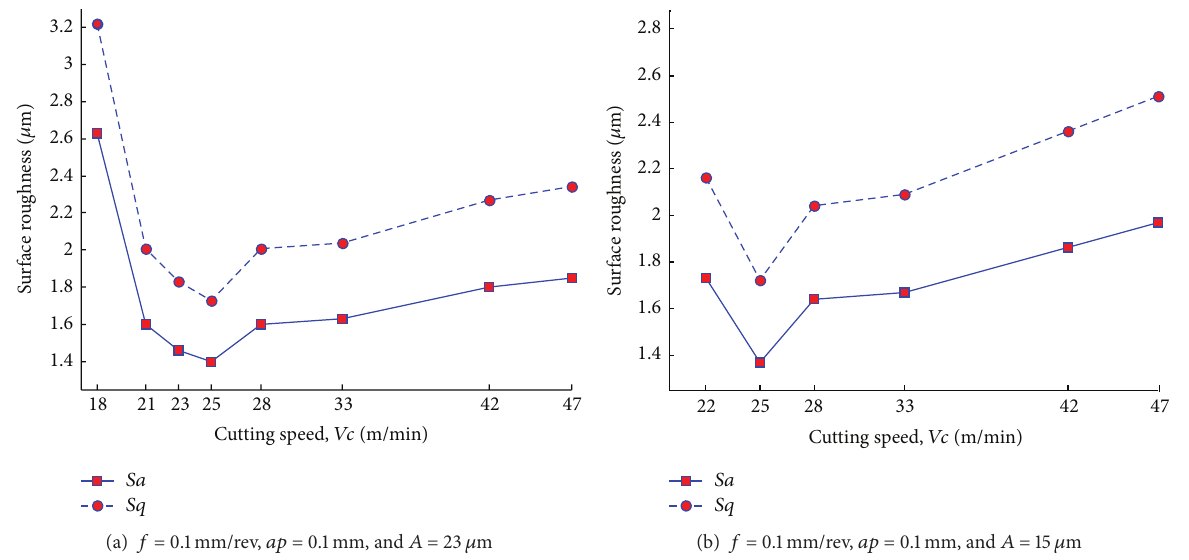
Figure 21: Relation curve of surface roughness changed with cutting